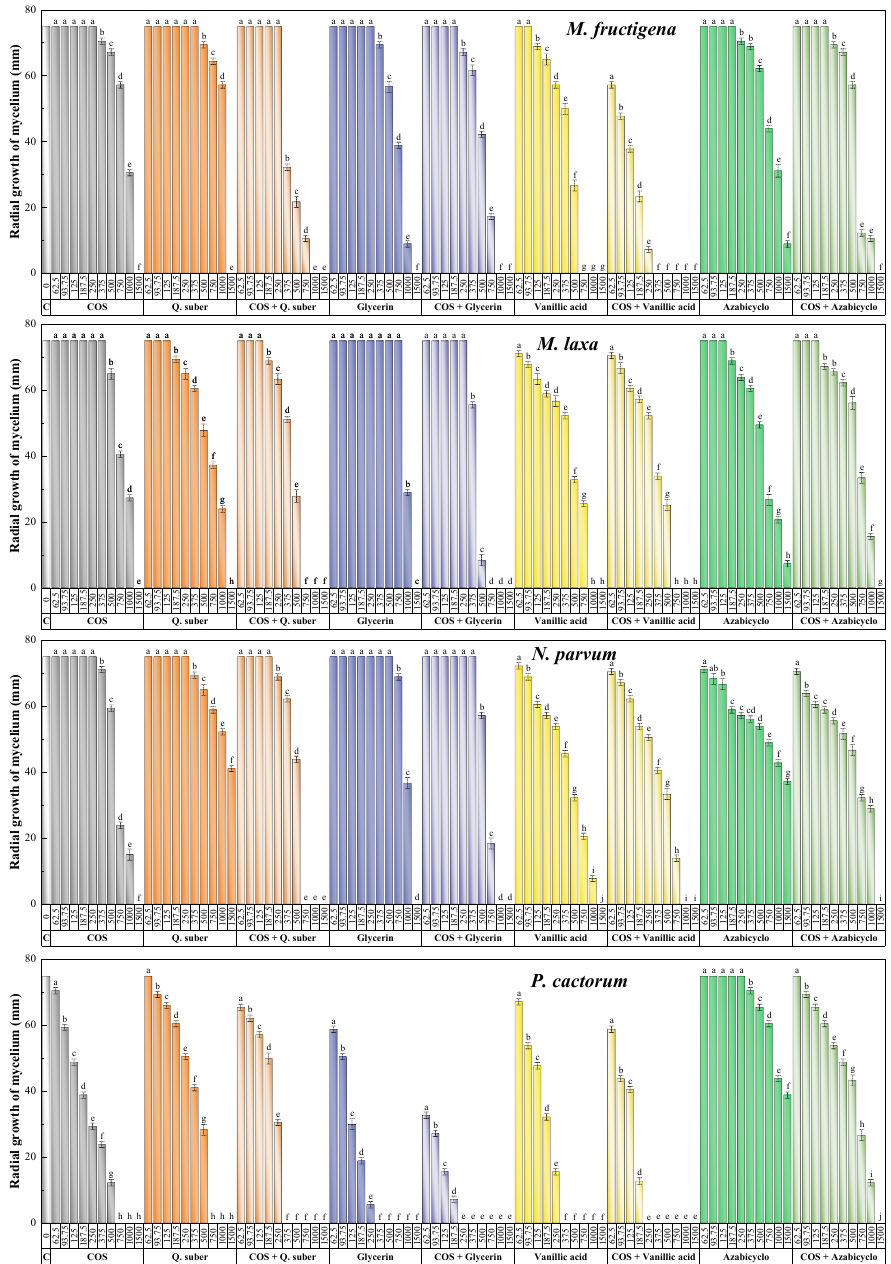
062 . 593 . 75125187 . 525037550075010001500 C Figure 2. Inhibition of the radial growth of the mycelium in in vitro tests performed in PDA medium with different concentrations (in the 62.5–1500 μ g·mL − 1 range) of chitosan oligomers (COS), Q. suber bark extract, three of its main phytochemical constituents, and their respective conjugated complexes. The same letters for the above concentrations mean that they are not significantly different at p < 0.05. Error bars represent standard deviations. Azabicyclo = 2-azabicyclo[2.2.1]heptane.